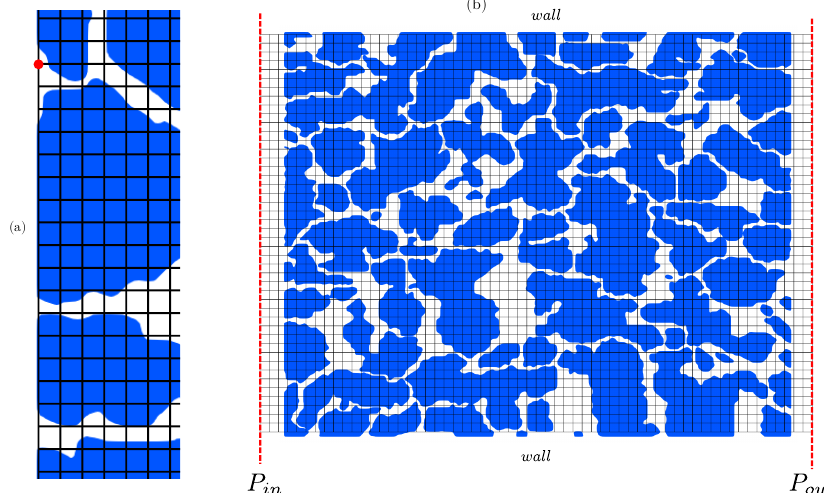
Figure 20. Sketch of the flow configuration: ( a ) upstream part of the domain without any buffer region and ( b ) full domain with inlet and outlet buffer regions and a thin layer removed in the y direction.